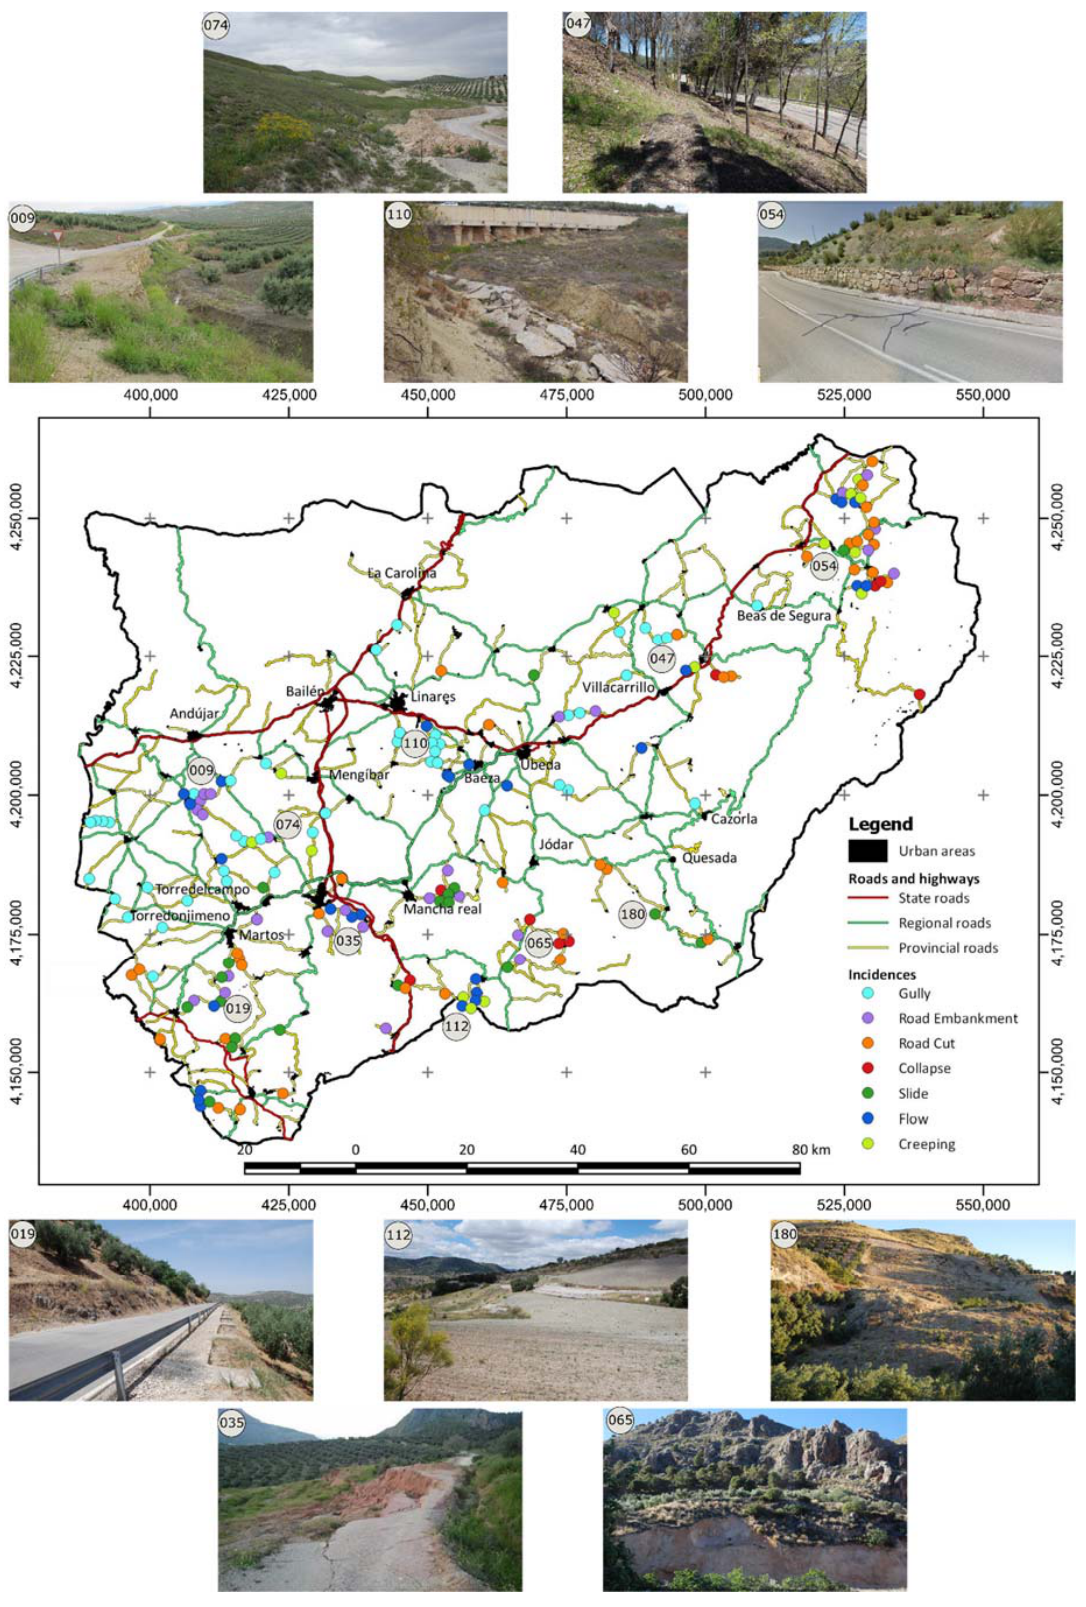
Figure 3. Map of incidences. Points: (009), gully; (019), undercutting of the road embankment; (035), flow; (047), creeping process; (054), slide in the road cut; (065), collapse over the road; (074), creeping process; (110), flow and gullies; (112), flow and creep; (180), slide in the slope of the road.